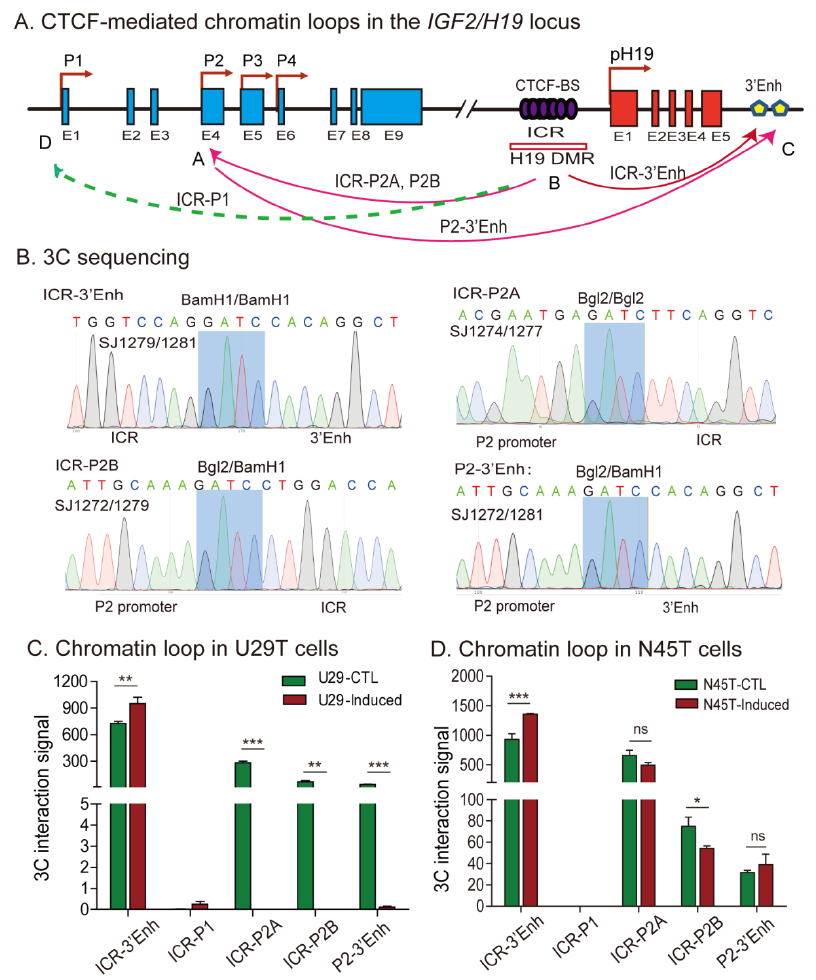
Figure 5. Intrachromosomal loop interactions in the H19 / IGF2 imprinting locus. ( A ) Location of 3C primers used to detect the interaction between the IGF2 promoter, CTCT6, and H19 enhancer. P1–P4: IGF2 promoters. E1–E9: IGF2 exons 1–9. E1–E5: H19 exons 1–5. Enh: enhancers. Arrows: intrachromosomal interactions. ( B ) Sequencing of the IGF2 / H19 intrachromosomal loop 3C products. Blue background on the sequence: the 3C ligation product between the BamH1 and/or Bgl2 restriction sites. ( C , D ) Quantitation of 3C intrachromosomal interaction signals. The 3C interaction was quantitated by qPCR. U29T cells showed normal imprinting but exhibited IGF2 LOI after decidu- alization. Note the lack of intrachromosomal interaction in decidualized N29T cells. Decidualized N45T cells with normal imprinting were used as the control. The data represent the mean ± SD from three independent experiments. * p < 0.05, ** p < 0.01, and *** p < 0.001 as compared with the vector lentivirus control group (CTL). ns: Not statistically